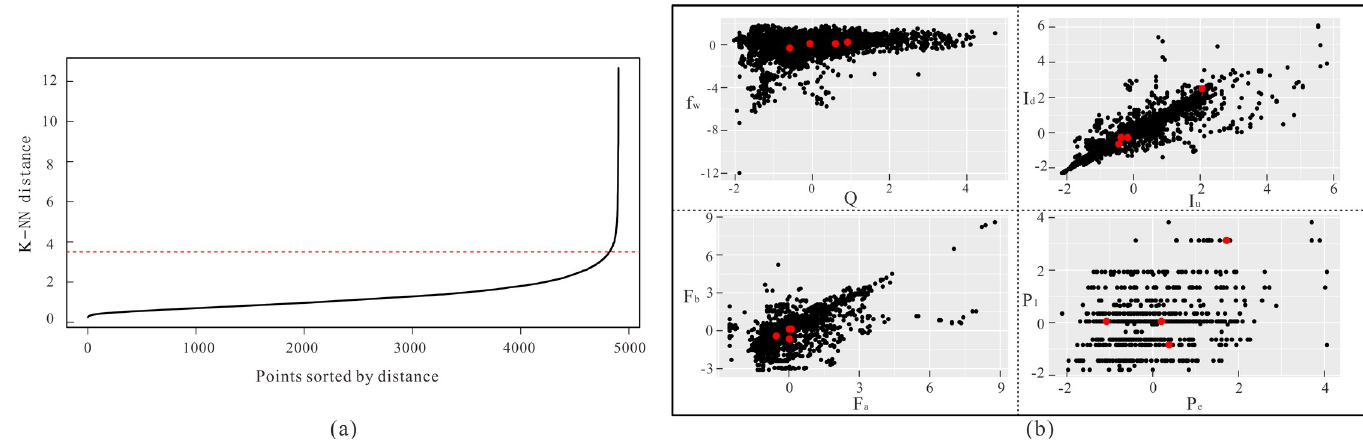
Fig 6. Initial cluster centre determination: (a) ε value determination; (b) Initial cluster centre plot.